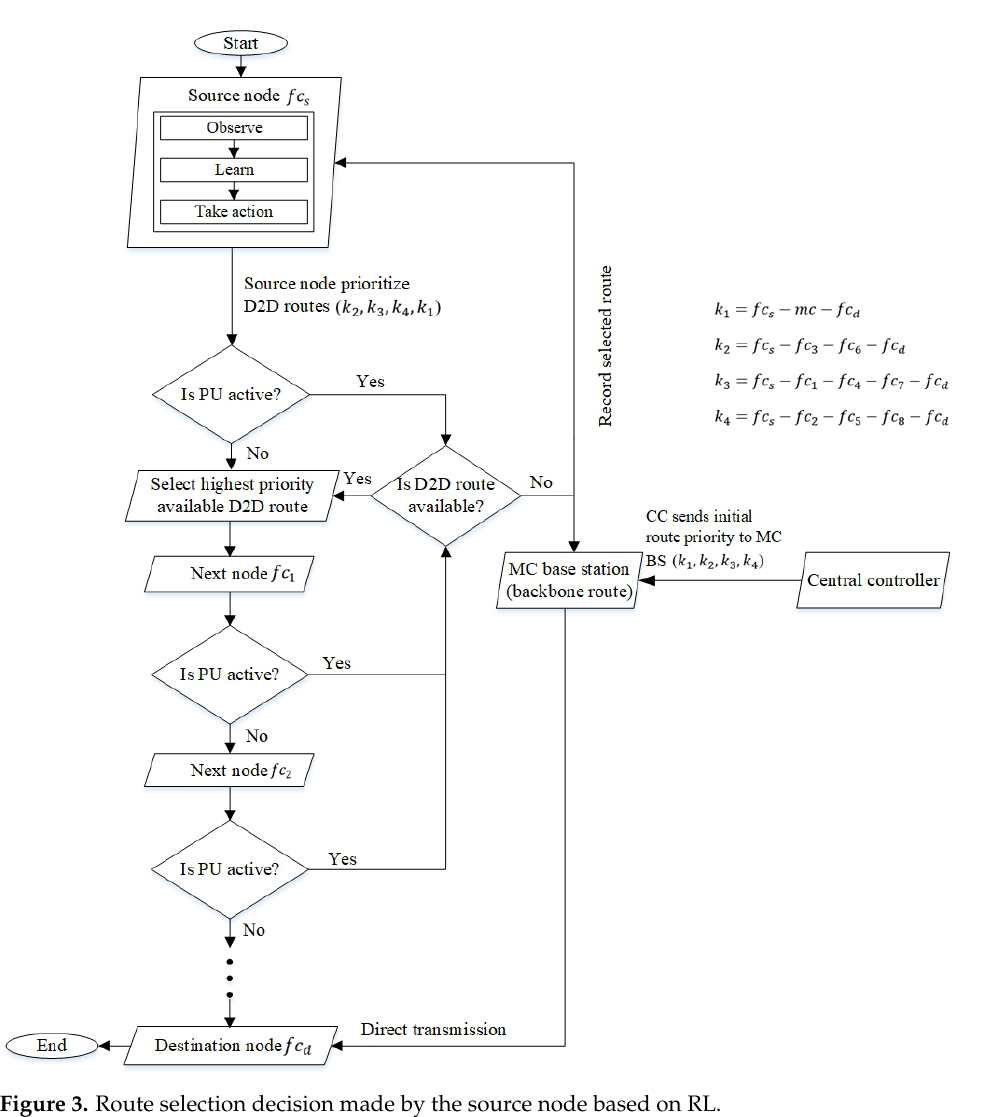
Figure 3. Route selection decision made by the source node based on